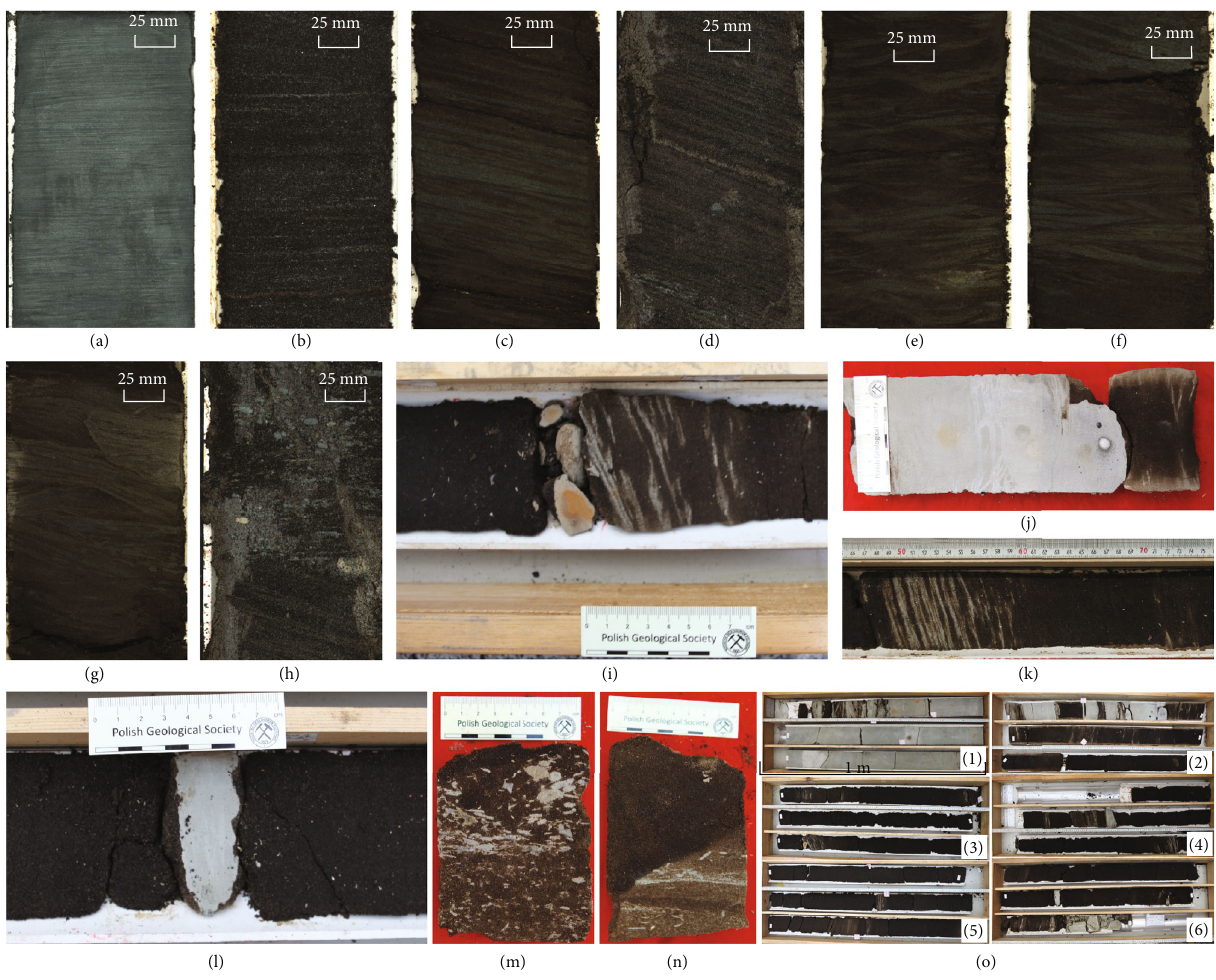
Figure 3: Core photos of Sedimentary structure in Guan6 4 : (a – h) core scan photos; (i – o) core photos. (a) Well 29-J246, 1287.20 m, green muddy siltstone, horizontal bedding. (b) Well 29-J246, 1337.90m, dust middle- fi ne-grained sandstone, parallel bedding. (c) Well 29-J254, 1287.1m, celadon middle- fi ne-grained sandstone, low-angle oblique bedding. (d) Well 29-J246, 1334 m, dust middle- fi ne-grained sandstone, high-angle oblique bedding. (e) Well 29-J254, 1286.7 m, celadon fi ne-grained sandstone, wavy cross-bedding. (f) Well 29-J254, 1286.9m, celadon fi ne-grained sandstone, trough cross-bedding. (g) Well 29-J254, celadon middle- fi ne-grained sandstone, trough cross- bedding. (h) Well 29-J246, 1333.80 m, celadon mud pebble middle grained sandstone, scouring surface. (i) Well 29-J254, mud gravel sandstone, gravel-scouring surface deposition. (j) Well 29-J254, bottom of braided fi lling channel, calcium cementation, argillaceous siltstone. (k) Well 29-J254, fi ne-grained deposition with mud stripes. (l) Fine-grained deposition, fall silt seam. (m) Well 26-J286, suspending mud gravel deposition. (n) Scouring eroded channel surface. (o) Well 29-J254, irregular binary structure (thin mud at the top and thick sandstone at the